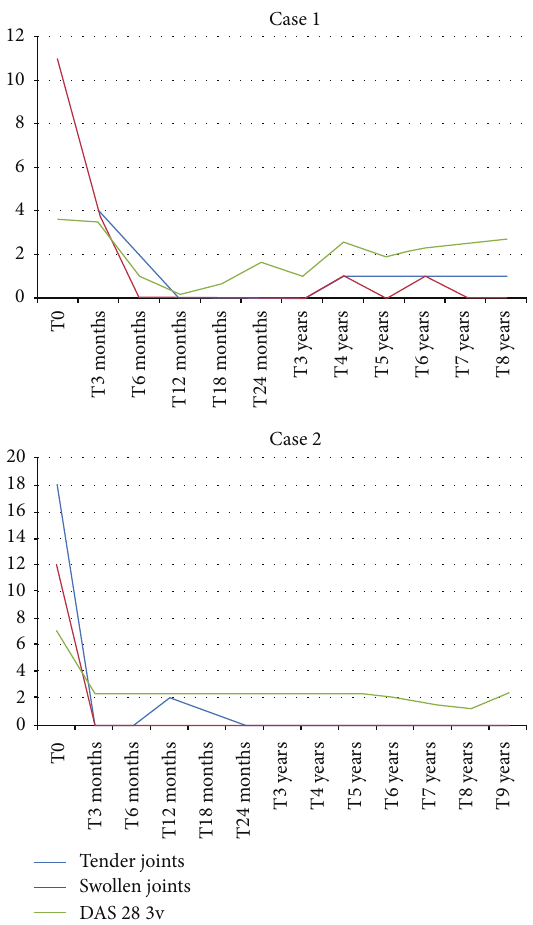
Figure 2: Evolution of the activity indexes in both cases; T0 refers to the first administration of infliximab.